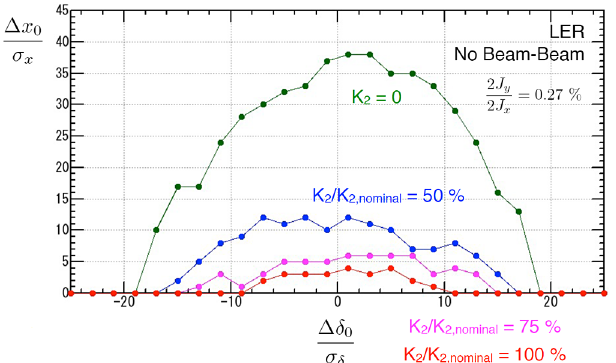
FIG. 6. Dynamic aperture for LER SuperKEKB with different crab sextupole strength.